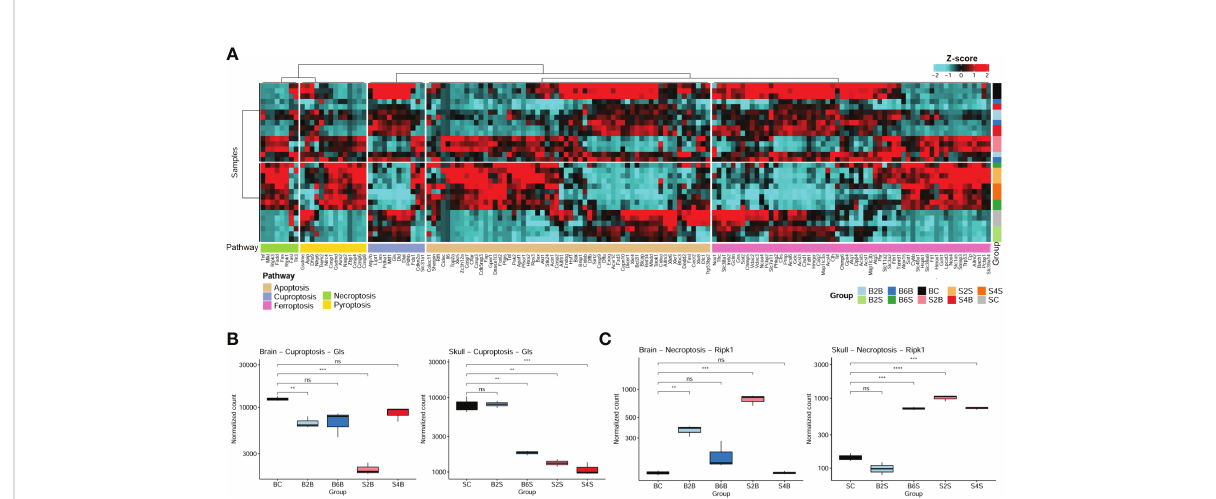
FIGURE 3 Expression patterns of the cell death pathway genes in brain and skull ischemic injury. (A) Heatmap of the genes in the cell death pathways (apoptosis, cuproptosis, ferroptosis, necroptosis, and pyroptosis pathways) for brain and skull ischemic injury. (B, C) Analysis of the changes in the representative genes Ripk1 (B) and Gls (C) associated with necroptosis and cuproptosis in brain and skull ischemic injury ( n = 3). ns , not signi fi cant. ** p < 0.01, *** p < 0.001, **** p < 0.0001. BC , control group for the uninjured brain; B2B and B6B , brain samples of the second and sixth days after brain photothrombosis (PT); SC , control group for the uninjured skull; S2S and S4S , skull samples of the second and fourth days after skull PT; B2S and B6S , skull samples of the second and sixth days after brain PT; S2B and S4B , brain samples of the second and fourth days after skull PT. ( A , the “ cluster_within_group ” function was used for the row and column clusters based on Pearson ’ s